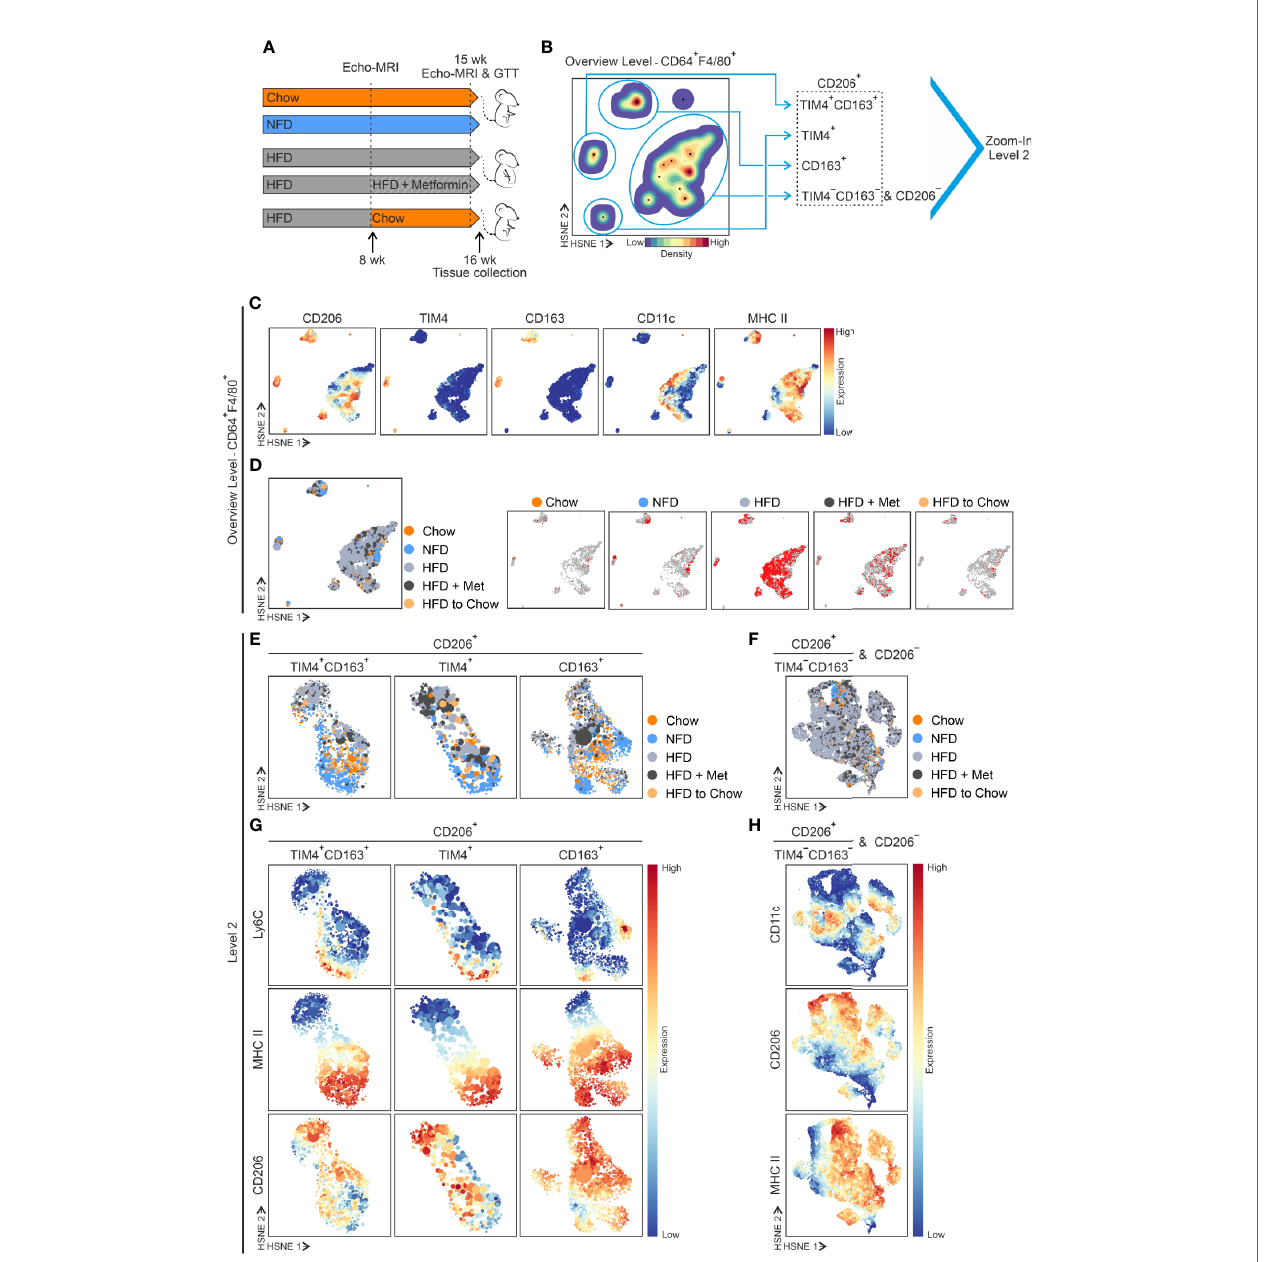
FIGURE 4 | Diet interventions induce alterations in ATMs. (A) Experimental setup of diet interventions. The standard diet is referred to as Chow, normal-fat diet as NFD, and high-fat diet as HFD. In the weight loss models, HFD fed mice were administrated with metformin (referred to as HFD + Met), or the diet was switched to Chow (referred as HFD to Chow) after 8 weeks on HFD (at 16 weeks of age). (B) Overview HSNE level (Level 1) embedding of CD64 + F4/80 + ATMs in eWAT at the end of the dietary experiments (cells from all study groups superimposed). HSNE level embedding shows density features (blue, low density; red, high density) depicting the local probability density of cells. The black dots indicate the centroids of identi fi ed cluster partitions. Blue encirclement indicates manual selection of the major ATM populations representing TIM4 + CD163 + , TIM4 + , CD163 + , and the merged TIM4 − CD163 − and CD206 − ATMs. (C) Expression of the indicated markers. (D) The left-hand blot: Contribution of cells from the fi ve different diet groups (color-coded as indicated) to the different HSNE density clusters (dark orange for Chow, light orange for HFD to Chow, light blue for NFD, light gray for HFD, and dark gray for HFD + Met). In the fi ve other plots: Each diet is embedded individually, and the red color presents the cells in the indicated diet group, and the gray color shows cells in the whole data set. (E) HSNE embedding representing a selection of TIM4 + CD163 + , TIM4 + , and CD163 + ATMs (Zoom level 2), demonstrating different diet groups with different colors as indicated. (F) Selection of merged CD206 + TIM4 − CD163 − and CD206 − ATMs in HSNE embedding representing different diet groups with different colors as indicated. (G) Expression of the indicated markers in TIM4 + CD163 + , TIM4 + , and CD163 + ATMs. (H) Expression of the indicated markers in merged CD206 + TIM4 − CD163 − and CD206 − ATMs. Indicated markers ’ expression intensity is shown from low (blue) to high (red). All mass cytometry data are from n = 8 (Chow), n = 8 (NFD), n = 16 (HFD), n = 8 (HFD + Met), or n= 10 (HFD to Chow)